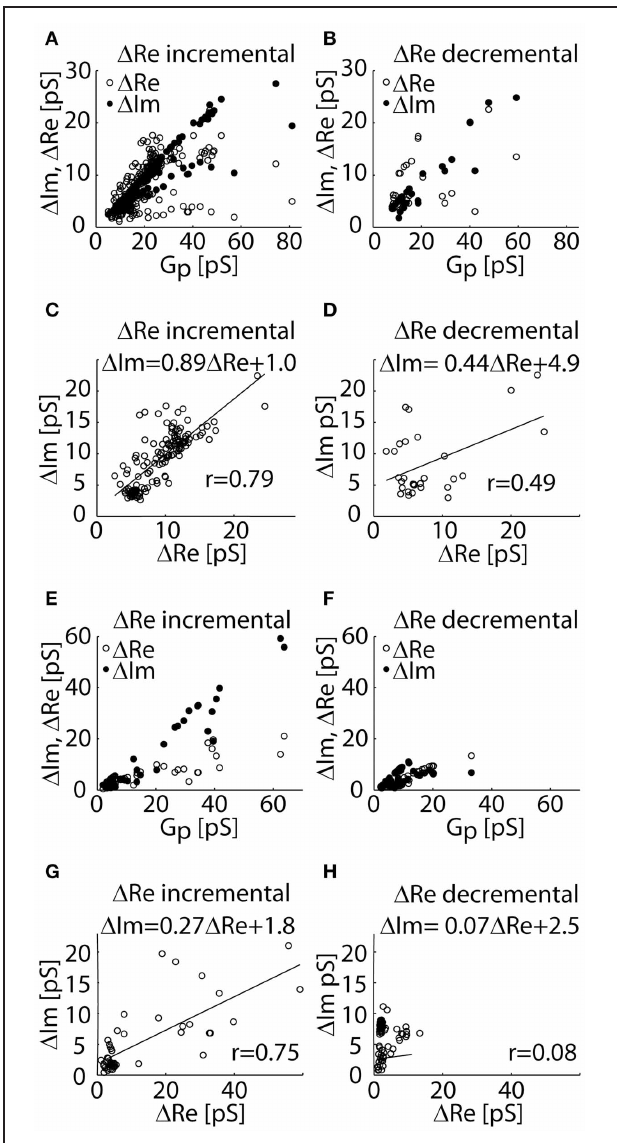
FIGURE 3 | The experimental datasets of (cid:2) Re and (cid:2) Im of admittance measurements recorded in lactotrophs (A–D) and astrocytes (E–H) incremental (case II) and decremental (case III) (cid:2) Re projections. The distributions of (cid:2) Re and (cid:2) Im as a function of G p for the datasets of incremental (cid:2) Re (A,E) and for the decremental (cid:2) Re (B,F) datasets. A scatter plot of (cid:2) Im against (cid:2) Re reveals a strong linear relationship in the incremental (cid:2) Re datasets of projections (C,E) , and a weak linear correlation in the dataset of decremental (cid:2) Re projections (D,H) .